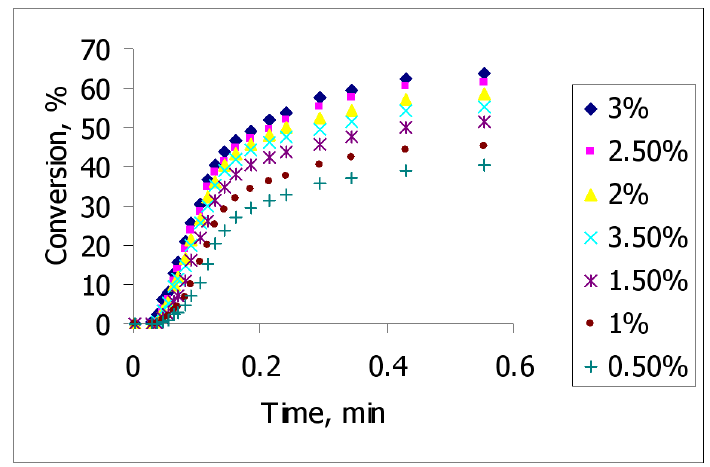
Fig. 9 Conversion versus exposure time for different photoinitiator concentration at 30 ◦ C, in the presence of 3% (w/w) TEA.